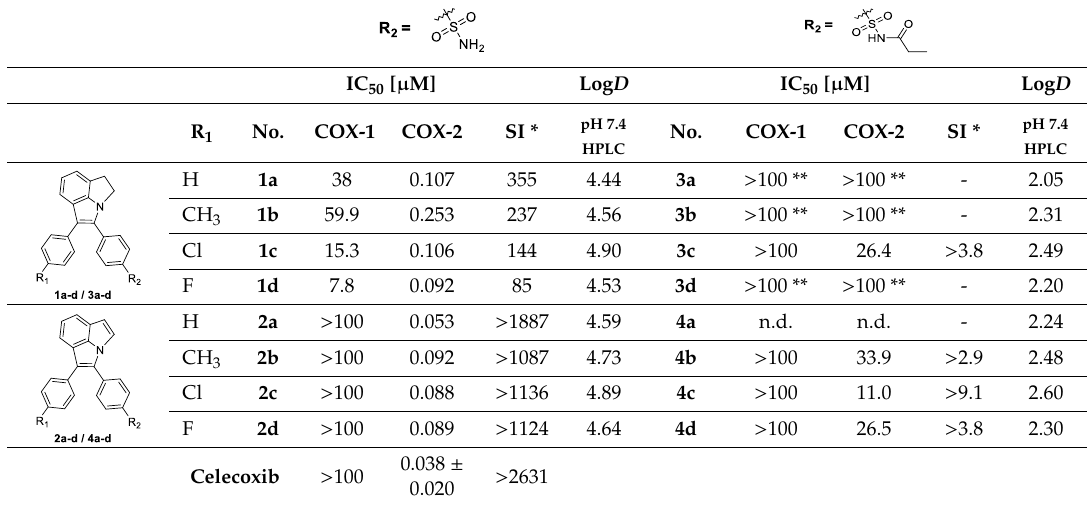
Molecules 2019 , 24 , x FOR PEER REVIEW 4 of 14 Kit,” Item No. 700100, Cayman Chemical, Ann Arbor, MI, USA). Celecoxib served as a reference. The results are shown in Table 1. Table 1. COX-inhibitory activity of 1,2-dihydropyrrolo[3,2,1- hi ]indoles and pyrrolo[3,2,1- hi ]indoles.